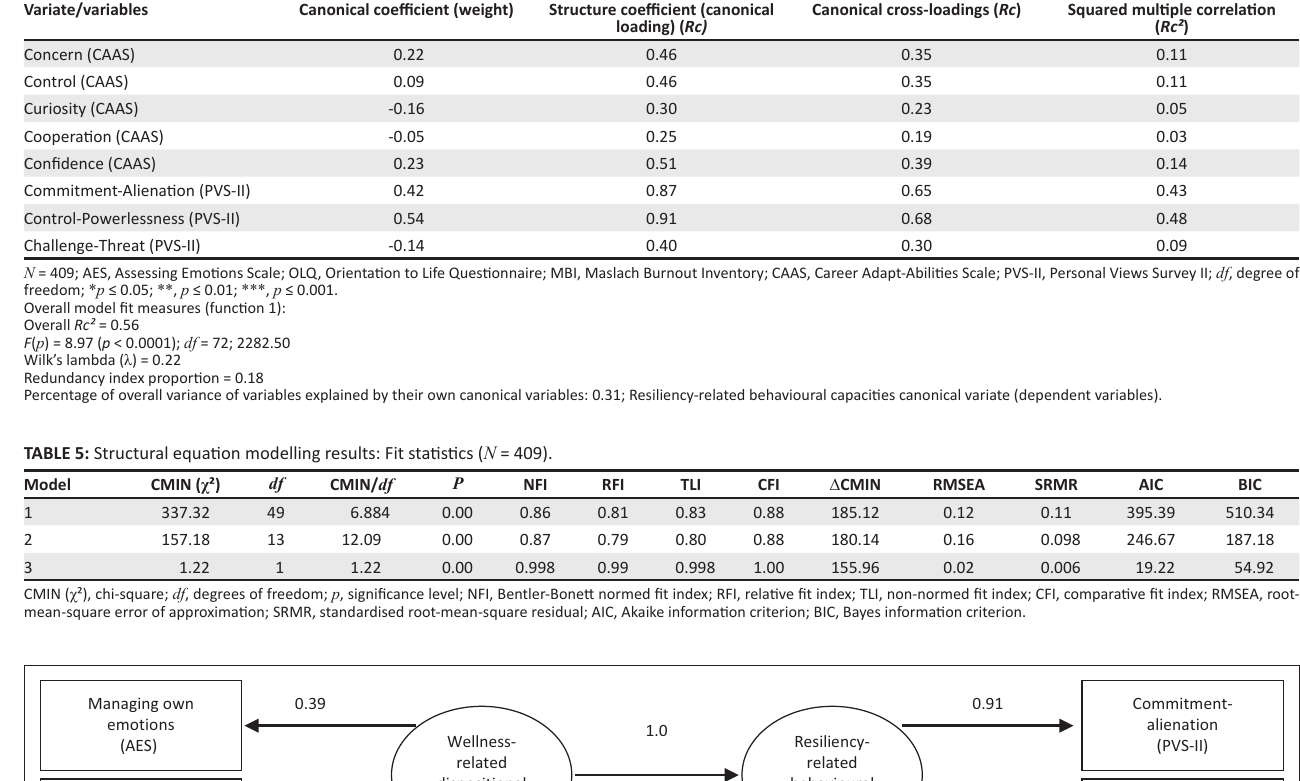
Control- powerlessness